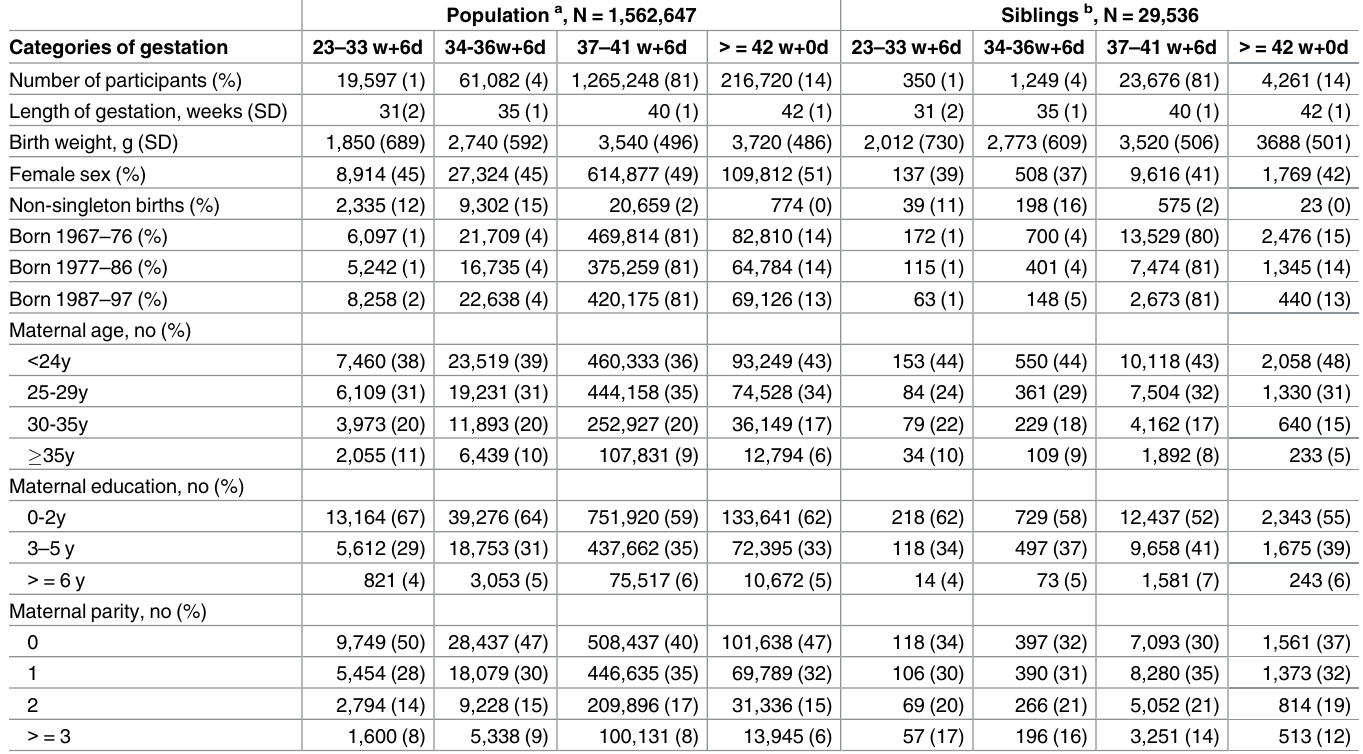
Table 1. Baseline characteristics of a nationwide population cohort and a sibling based study born in Norway